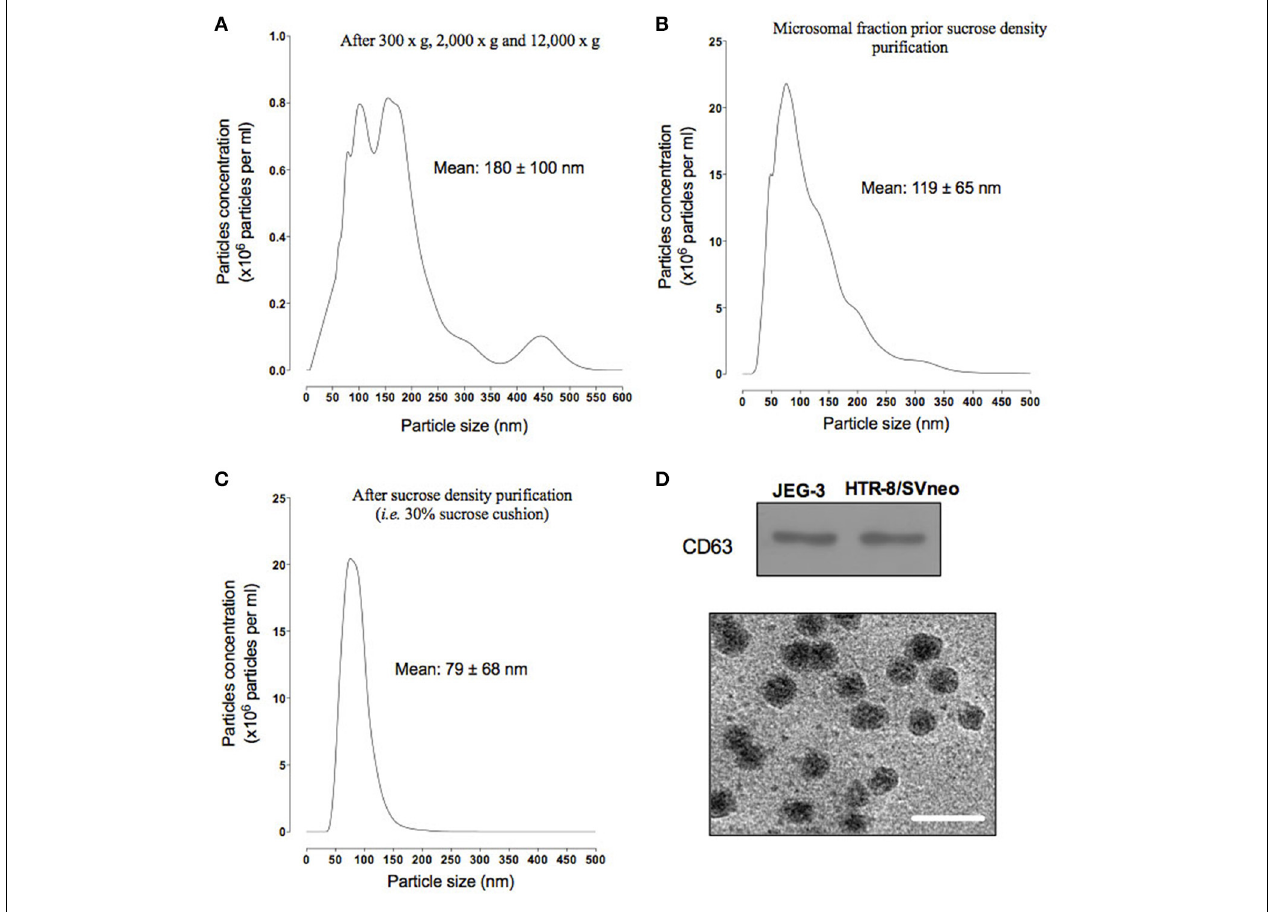
FIGURE 2 | Characterization of exosome from EVT cells. Exosomes were isolated from JEG-3 and HTR-8/SV cells by differential and buoyant density centrifugation (see Materials and Methods). (A–D) shown representative particles size distribution of exosomes isolation steps from JEG-3 and HTR-8/SV cells. (A) After differential